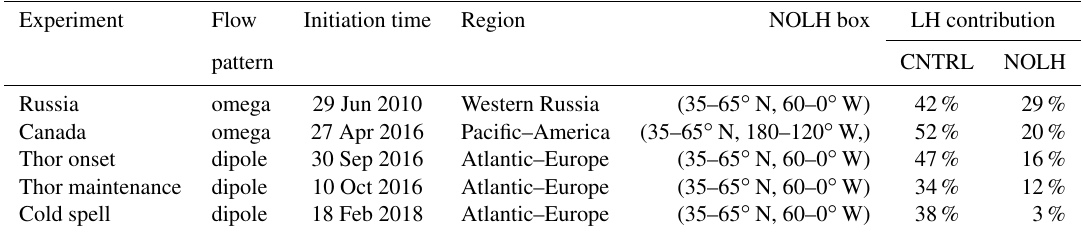
Table 1. Selected historical blocking events. The LH contribution has been determined from backward trajectory calculations. The initializa- tion time is the same for both CNTRL and NOLH simulations. Note that “Thor onset” and “Thor maintenance” are different phases of the same blocking